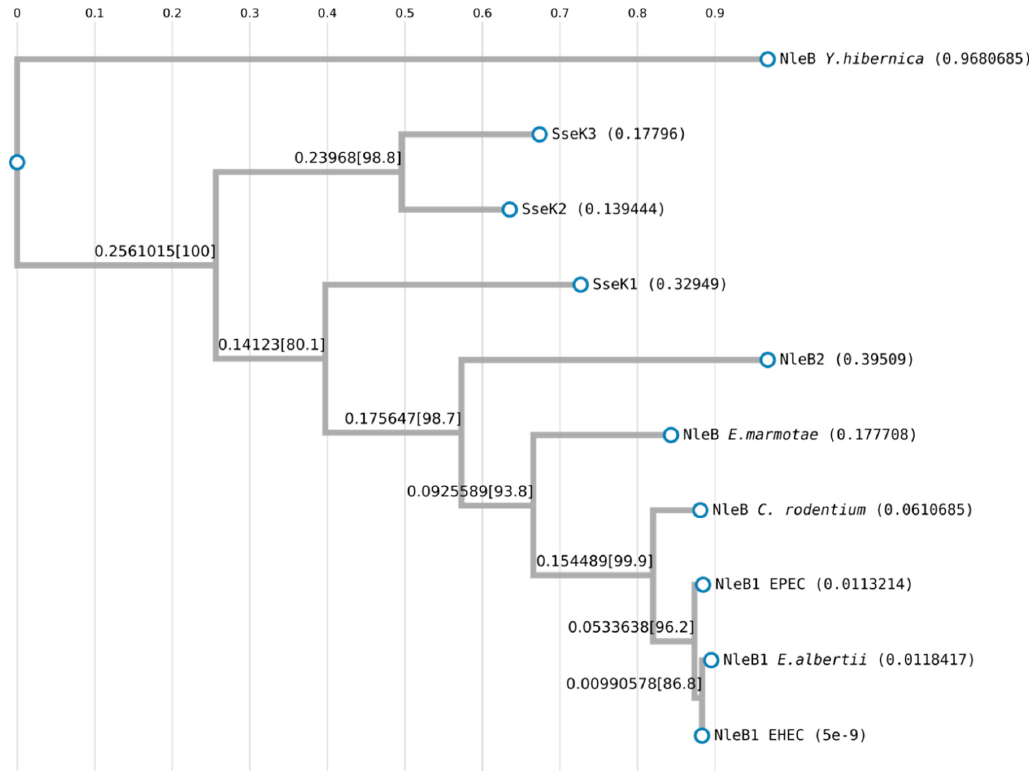
Figure 4. Phylogenetic analysis of NleB/SseK proteins. Alignment and phylogenetic reconstructions were performed using the function “build” of ETE3 v3.1.1 [118] as implemented on the GenomeNet (https://www.genome.jp/tools/ete/). The tree was constructed using FastTree v2.1.8 with default parameters [119]. Values at nodes are SH ‐ like local support.